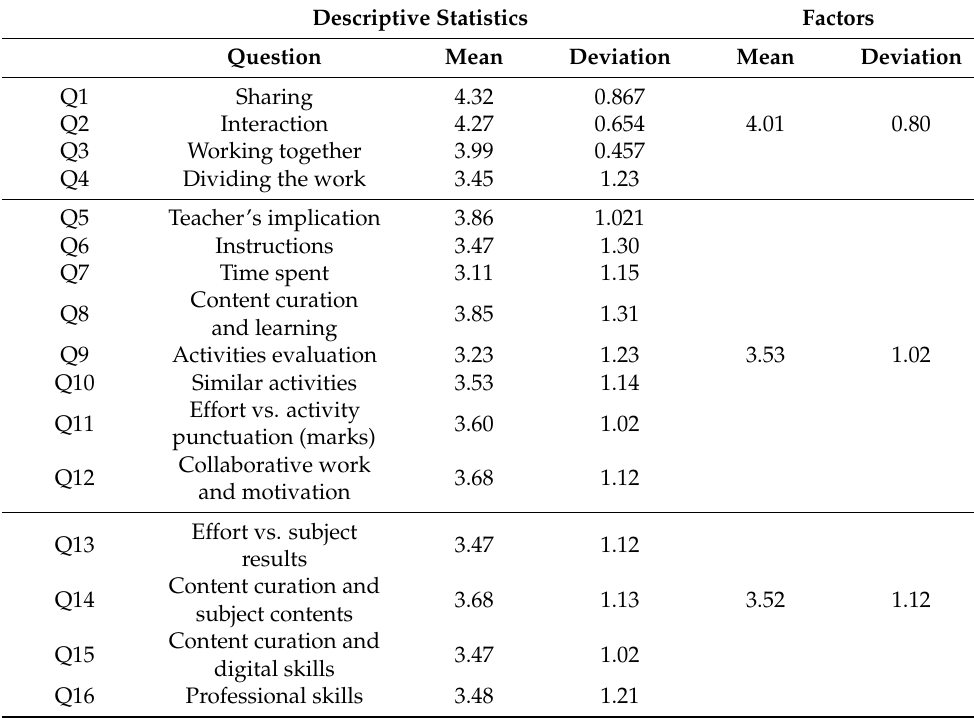
Table 5. Descriptive statistics and factors obtained from the questionnaire